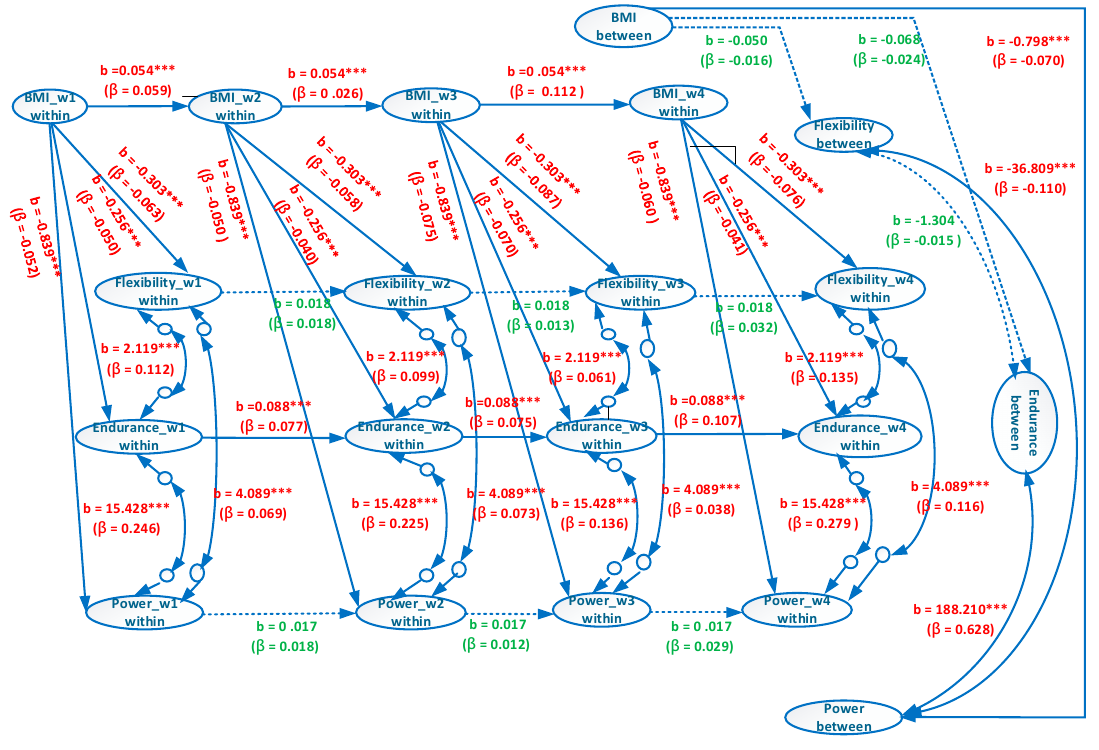
Figure 2. Simplified representation of the estimated random intercept panel model of all samples.